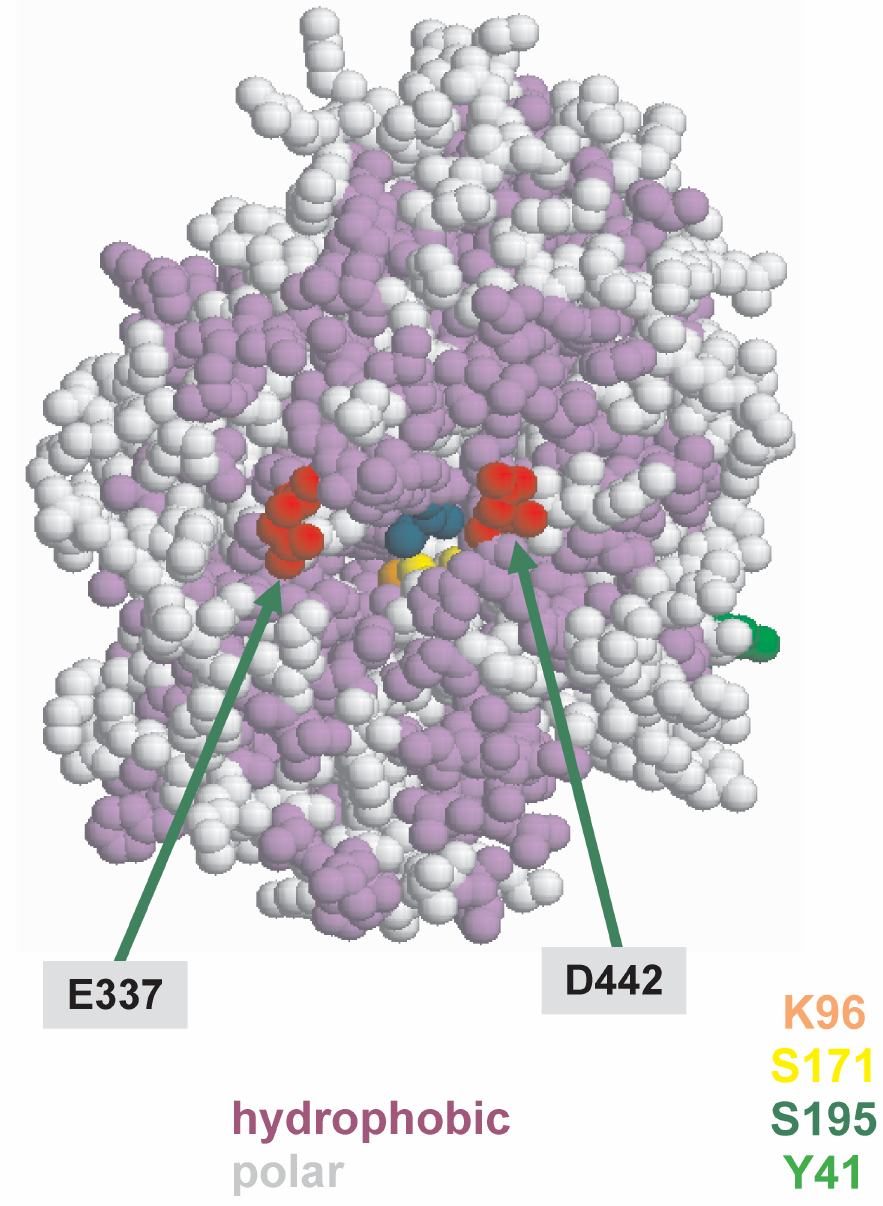
Figure 9. Hydrophobic and charged residues around the entrance of the Sulfolobus solfataricus amidase active